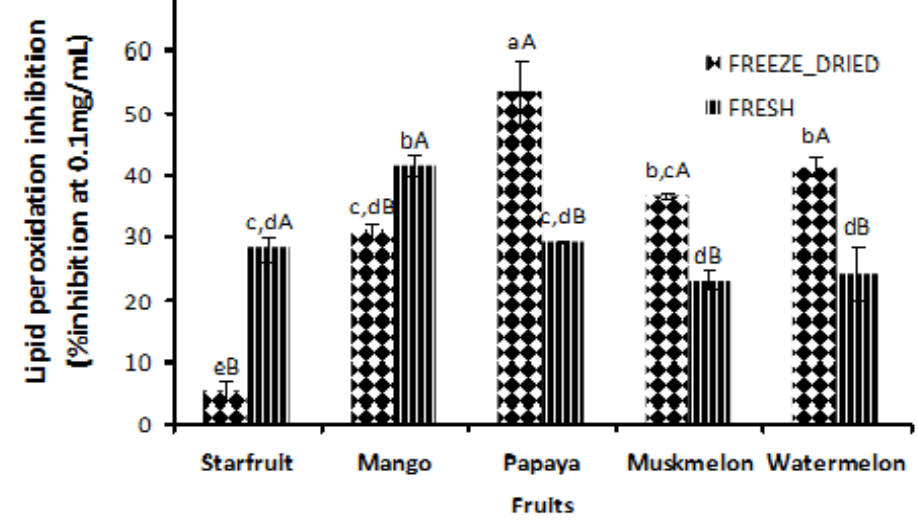
Figure 3. Antioxidant activity (in terms of lipid peroxidation inhibition) as measured by conjugated diene assay of fresh and freeze-dried fruits. Data expressed as % inhibition at 0.1 mg/mL. Values denoted with the same small letter are not significantly ( p > 0.05) different among fruits tested. Values with the same capital letter are not significantly ( p > 0.05) different between the fresh and freeze-dried fruits. Data stand as means of three